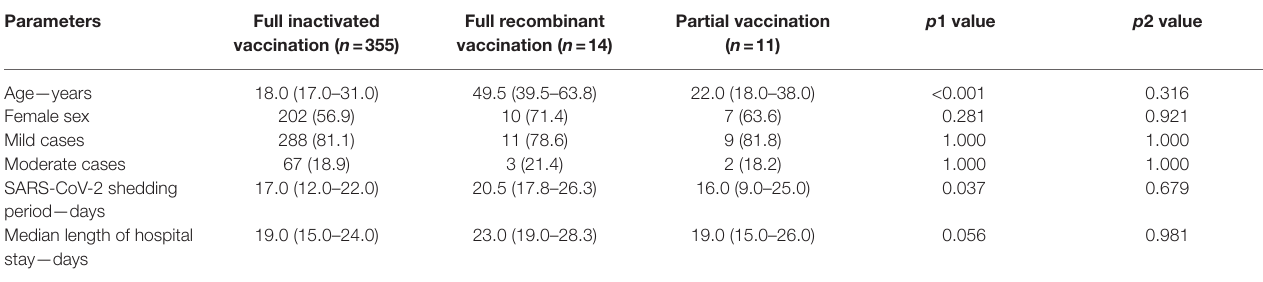
TABLE 7 | Clinical outcomes in patients with various vaccination conditions. Parameters Full inactivated Full recombinant Partial vaccination vaccination ( n = 355) vaccination ( n = 14) ( n =